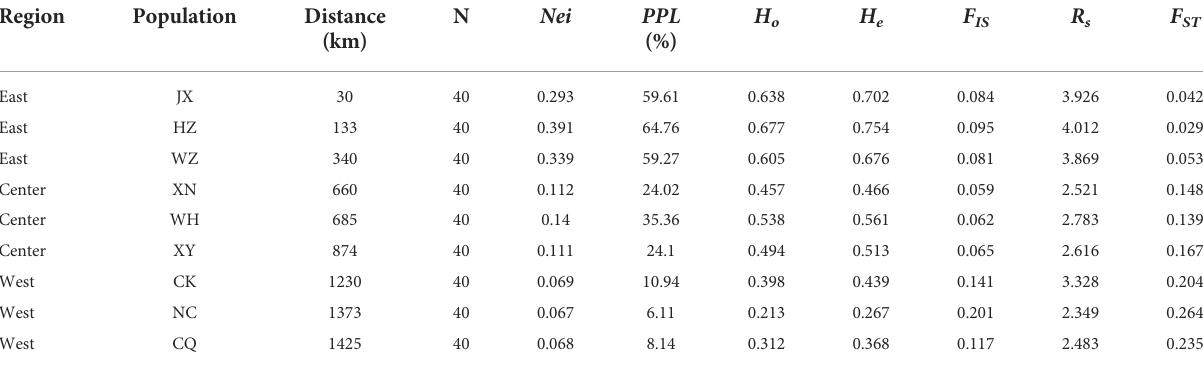
TABLE 1 Statistical comparisons of genetic diversity indices for E. annuus in wild population. Distance, distance to the fi rst recorded point of introduction; N, number of samples; Nei, Nei ’ gene diversity; PPL, the percentage of polymorphic loci; H o , observed heterozygosity; H e , expected heterozygosity; F IS , inbreeding coef fi cient; R s , allelic richness and F ST , genetic differentiation index.